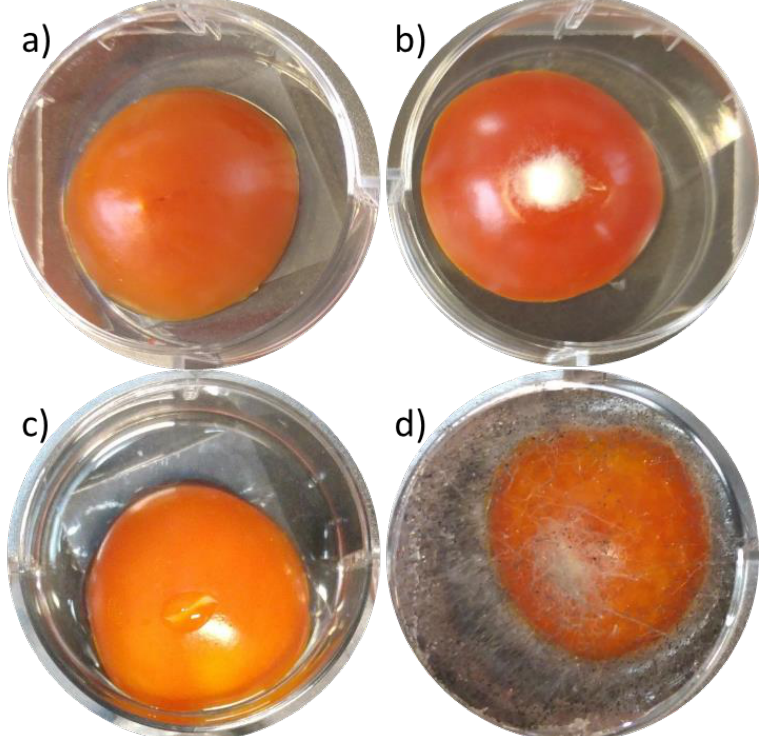
Figure 4. Antifungal effects of the carvacrol-containing films exhibited in the micro-atmosphere bioassays, i.e. without direct contact between the studied films and the microbial cultures using cherry tomatoes as the food model. ( a ) full inhibition of A. alternata development after incubation with a 9-layer (LDPE/[HNTs/carvacrol])/EVOH film; ( b ) A. alternata development after incubation with a 9-layer LDPE/EVOH film; ( c ) full inhibition of Rhizopus spp . development after incubation with a 9-layer (LDPE/[HNTs/carvacrol])/EVOH film; ( d ) Rhizopus spp . development after incubation with a 9-layer LDPE/EVOH film. The cherries were incubated with the films at 23 °C in the dark for 4 days. The results presented in ( a , c ) are characteristic for all carvacrol-containing films. The results presented in ( b , d ) are characteristic for all carvacrol-free films. All photographs were taken after the top and circumference films were